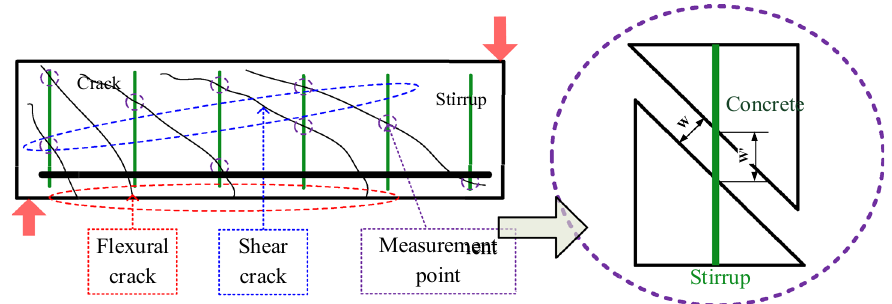
Fig. 9 Measuring cracks of various types at various positions in a